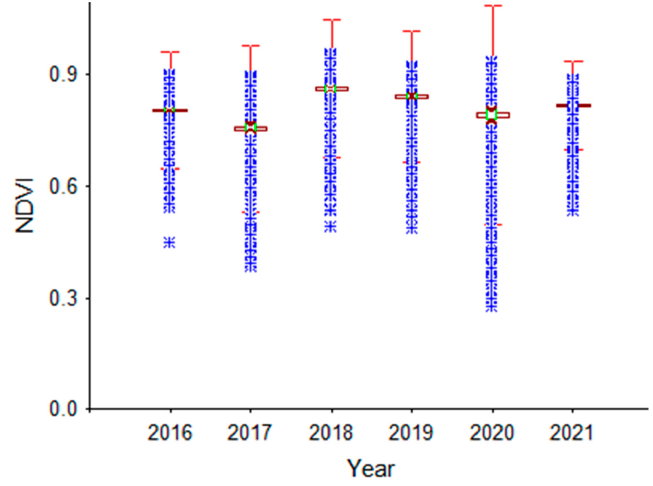
Figure 5. NDVI data (from soybean, corn, and wheat in rotation) for the month of July (2016–2021). The spatial pattern of NDVI values for the month of July from 2016 to 2021, by soybean, corn, and wheat in rotation, is presented in Figure 6. As seen from Figure 6a,f, the NDVI values were almost constant for many pixels in 2016 and 2021. By contrast, the NDVI values were nonuniform for 2017 and 2020. The lowest NDVI values in 2017 and 2020 were observed in the southwest and the northwest of the studied area, respectively, for many pixels (Figure 6b,e).